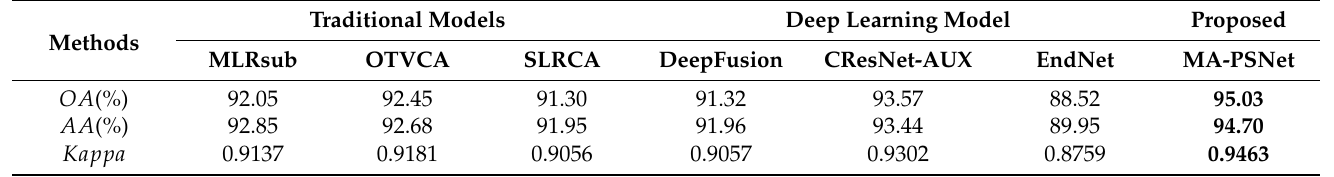
Table 5. Comparisons of classification accuracy with different models on Houston 2013